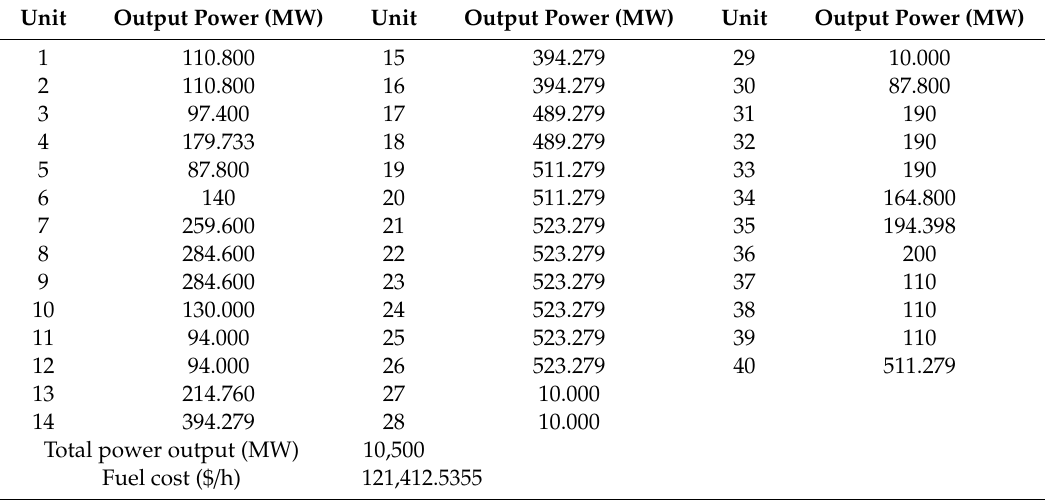
Table 11. Best outputs for test case 3 with PD = 10,500 MW (40-units system).